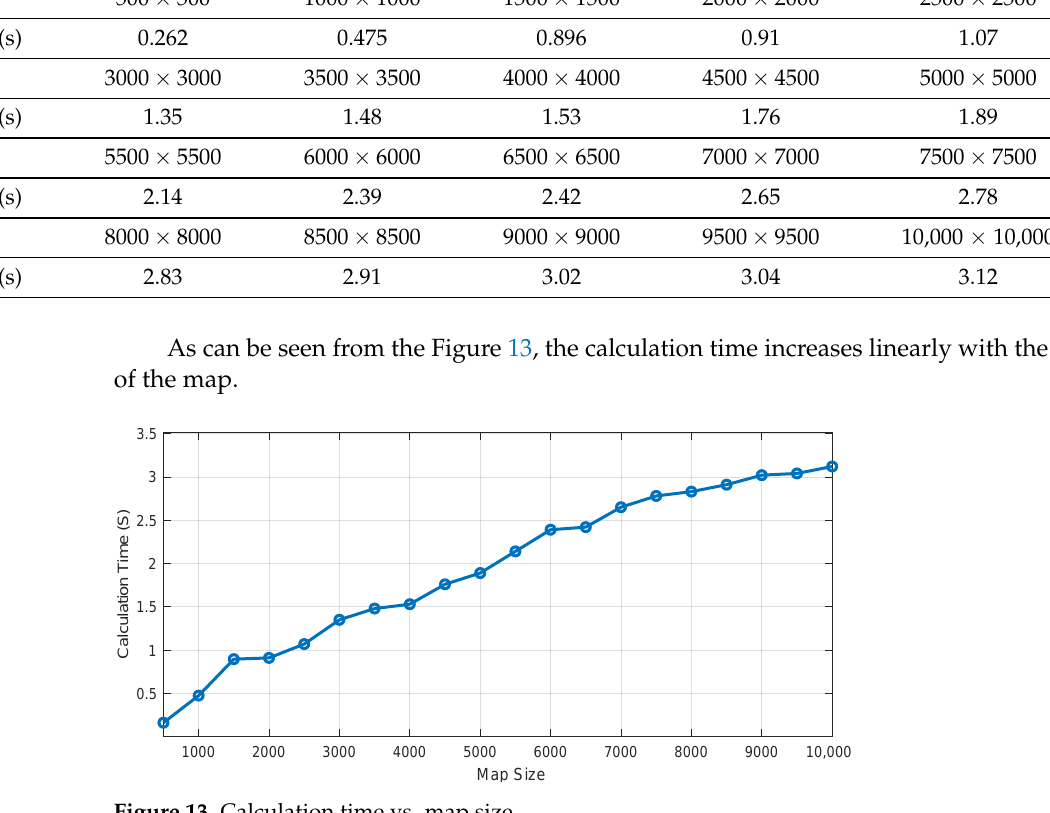
Figure 13. Calculation time vs. map size.